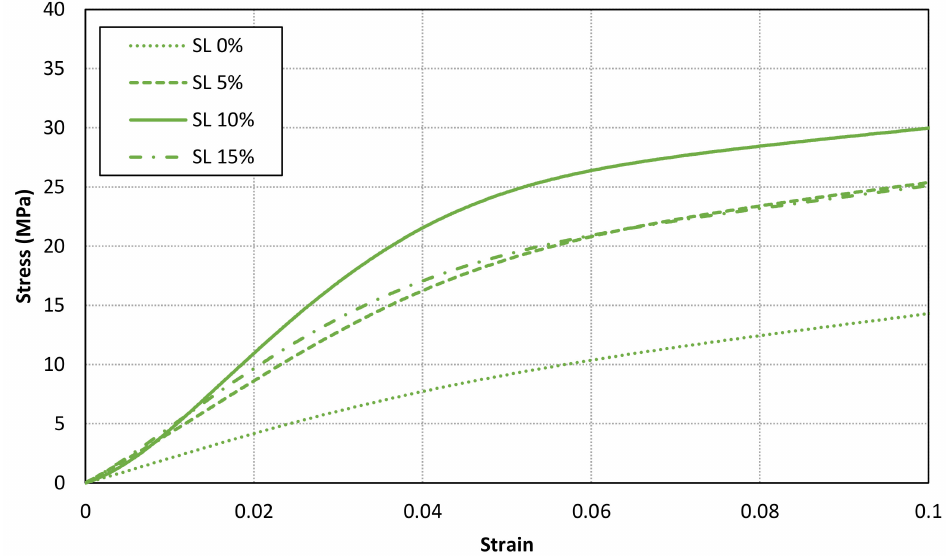
Figure 13. Stress-strain curves for a representative compression sample for each solid load content for Z orientation.